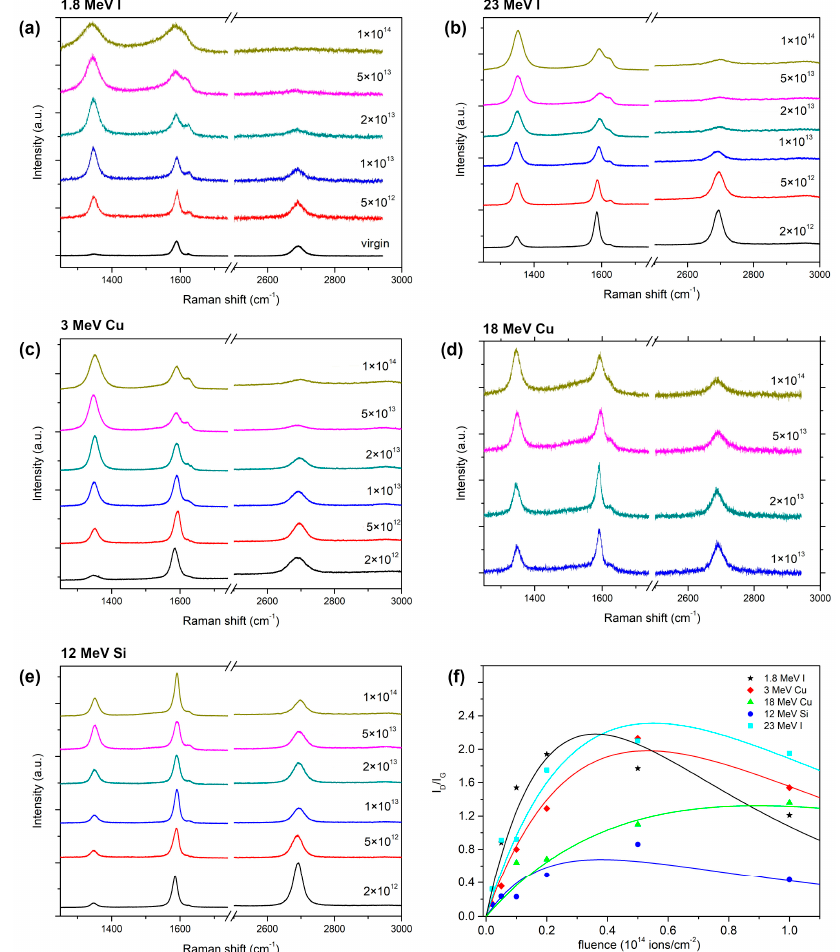
Figure 1. Raman spectra (532 nm excitation wavelength) of BLG samples irradiated with ( a ) 1.8 MeV I, ( b ) 23 MeV I, ( c ) 3 MeV Cu, ( d ) 18 MeV Cu, and ( e ) 12 MeV Si. Ion fluences (depicted by